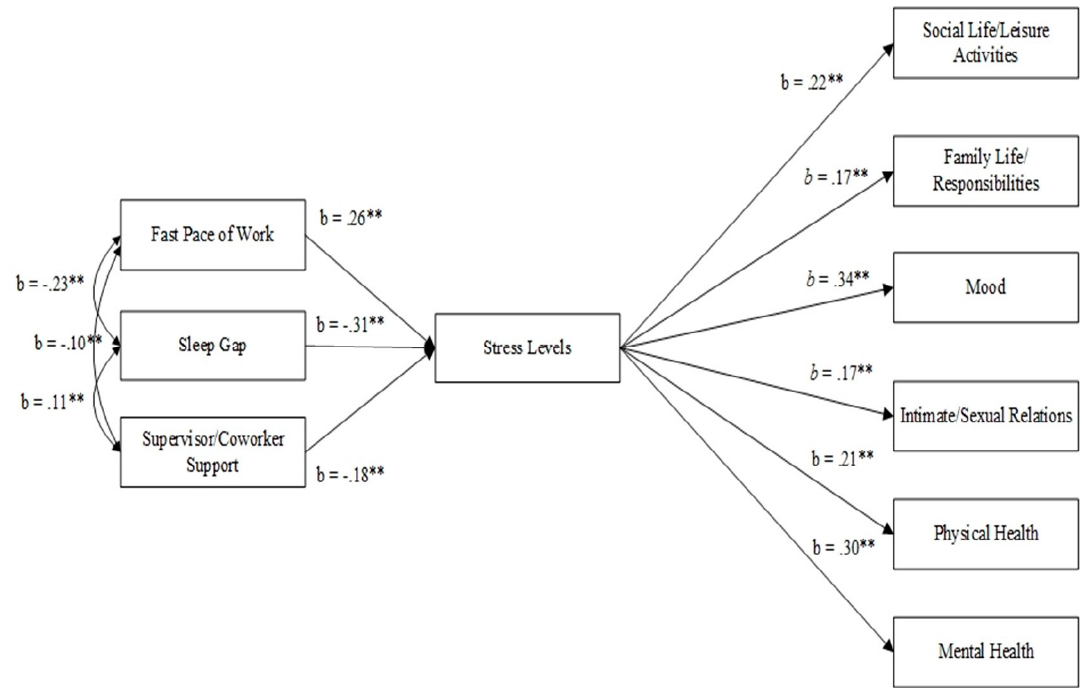
Figure 2. Structural equation model displaying the relationships between: pace of work; sleep gap; workplace social support; perceived job stress; and sleep’s impact on work-life balance. ** p < 0.01.